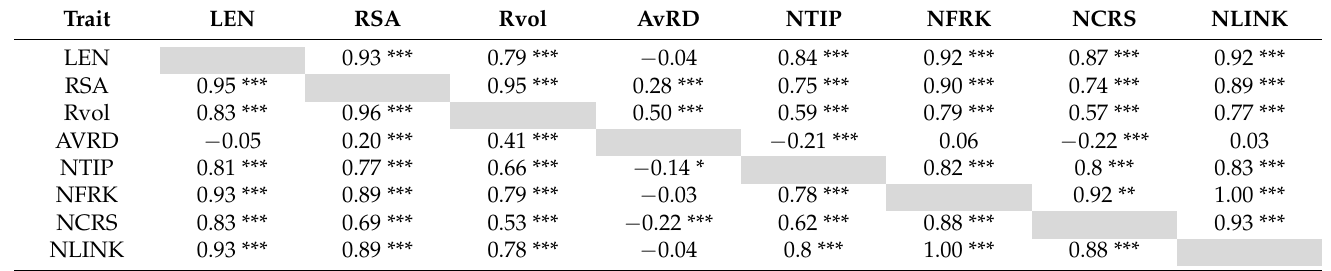
Table 1. Pearson correlation of seven root traits of 262 Andean common bean genotypes grown under control (above diagonal) and aluminum (below diagonal) treatment